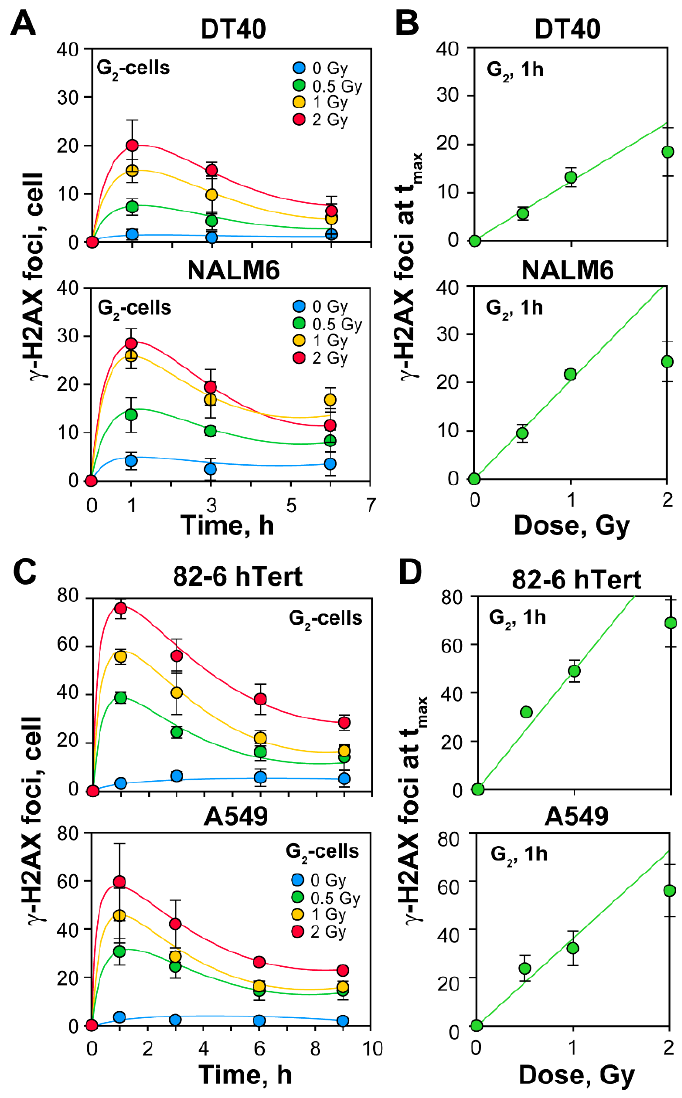
Figure 2. Formation of γ -H2AX repair foci indicates a linear increase of DSBs with increasing radiation dose: ( A ) Repair kinetics of γ -H2AX foci formation and decay in DT40 and NALM6 cells; ( B ) Quantitative analysis of γ -H2AX foci in lymphoblastoid cell lines; ( C ) Same as in Figure 2A, but for human 82-6 hTert and A549 cell lines; ( D ) Same as in Figure 2B, but for human 82-6 hTert and A549 cell lines. Dose response curves are derived from the repair kinetic experiments shown in Figure 2A,C and represent the formation of γ -H2AX foci in G 2 -phase cells, 1h after IR exposure (t max ). Data is generated by QIBC analysis and represent the mean and standard deviation from 3 independent experiments.